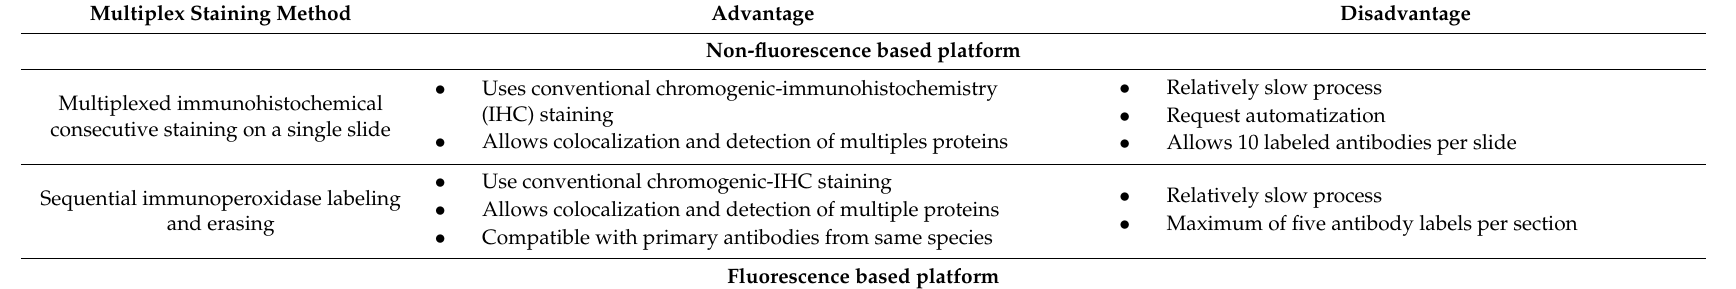
Table 1. Multiplex staining methodologies and their advantages and